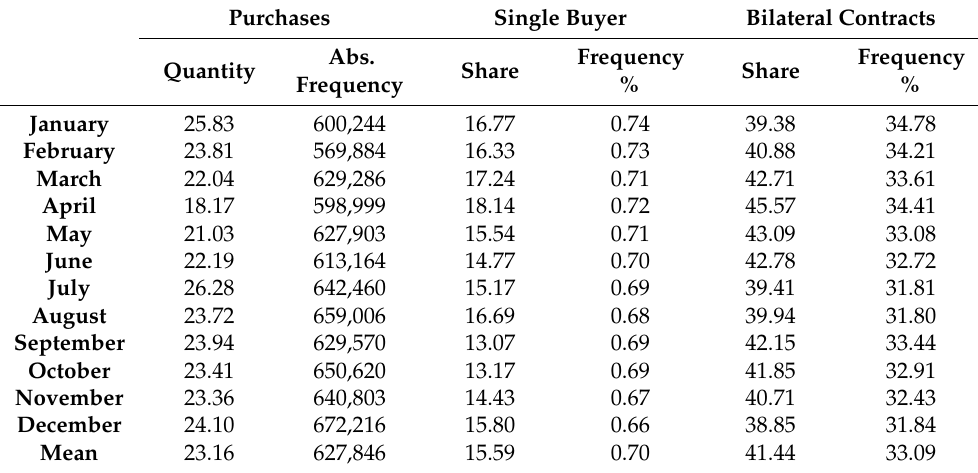
Table 4. Offer to Purchase (BID): Monthly Total Quantity and Absolute Frequency of Accepted Bids, Monthly Share and Relative Frequency Single Buyer and Bilateral